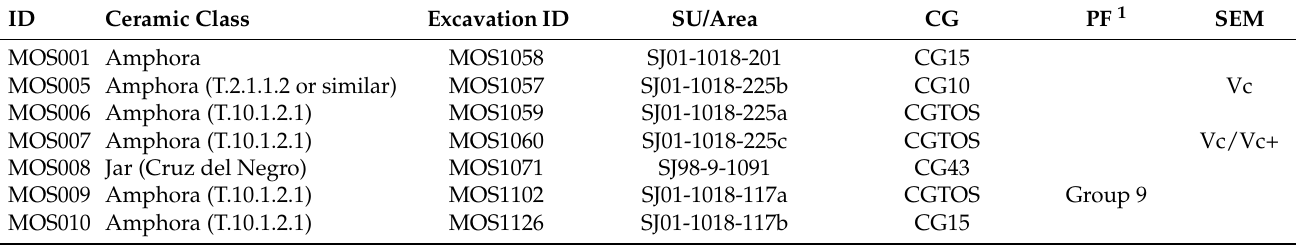
Table 1. List of individuals studied in the present paper. ID: identifier. SU: stratigraphic unit. CG: chemical groups (post-analysis); PF: petrographic fabric (post-analysis). *: observations made